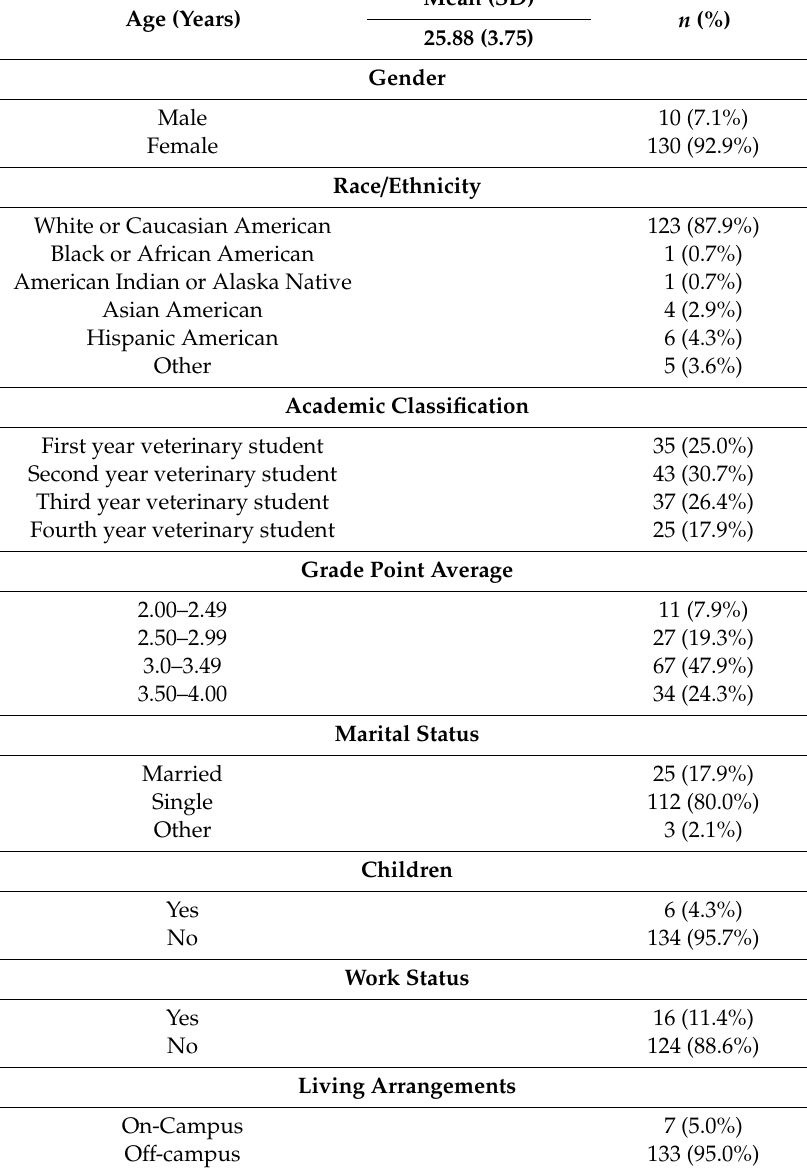
Table 1. Socio-demographic Characteristics of the Participants ( N =